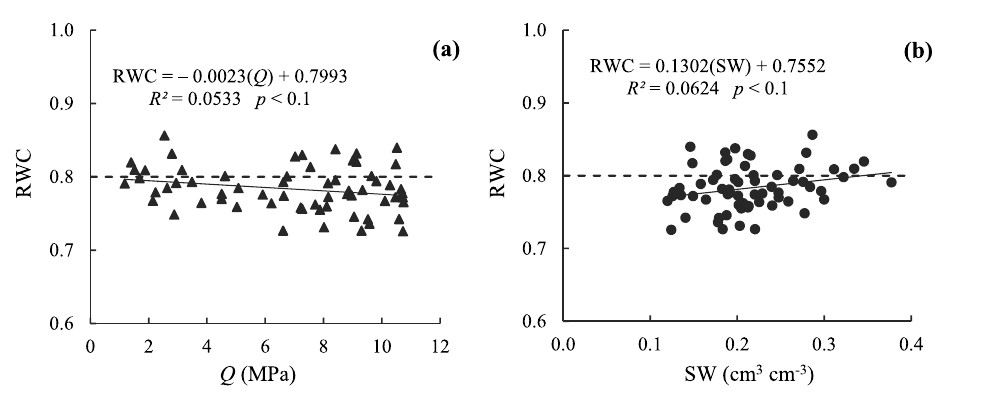
Figure 4. Linear relations betw e en RWC and Q ( a ) and RWC and SW ( b )